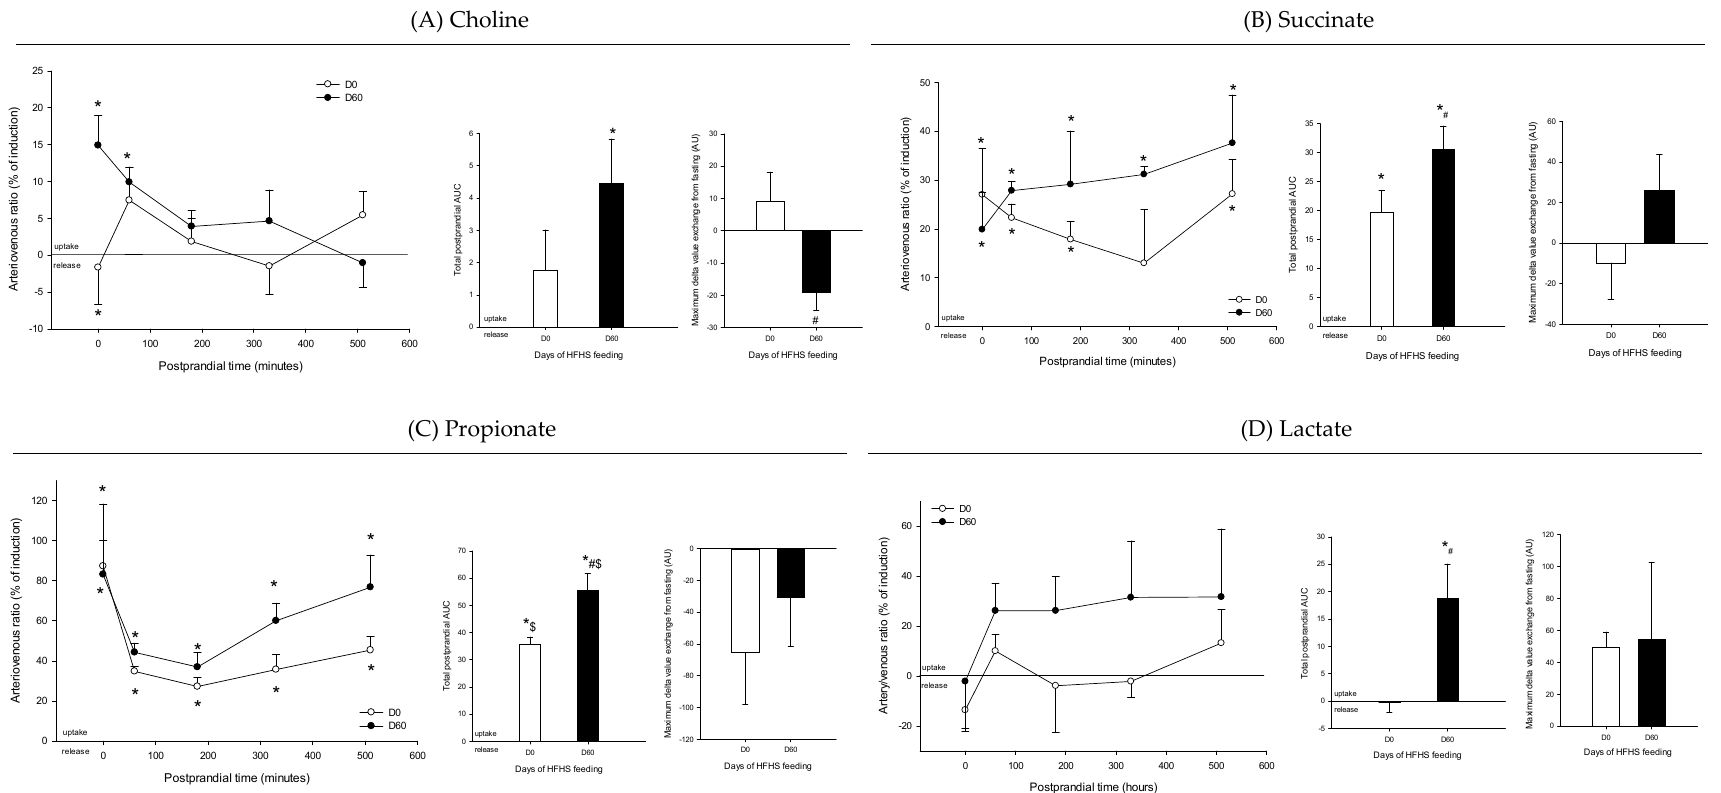
Figure 4. Arteriovenous fold change (A/V) of ( A ) choline, ( B ) succinate, ( C ) propionate, and ( D ) lactate across the liver on five Yucatan mini-pigs submitted to a HFHS diet during two months. Data is presented in % of induction (mean + sem) and the exchange was analyzed using a repeated-measures t -student test. *, significantly different from 0 (equilibrium), p < 0.05. For the A/V ratios and total postprandial AUC, positive values = taken up by the organ; negative values = released by the organ. #, significantly different from D0, p < 0.05; $, significantly different from the fasting condition, p < 0.05. The maximum delta value exchange from fasting is also presented: the positive and negative values represent an increase or decrease exchange following the meal, respectively.